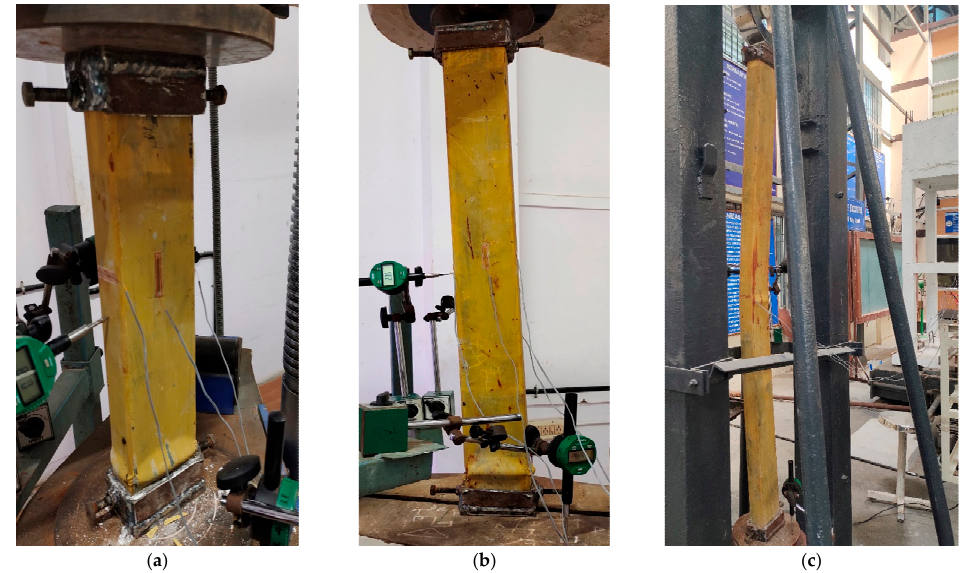
Figure 9. Failure modes in columns. ( a ) Stub column. ( b ) Short column. ( c ) Medium column.